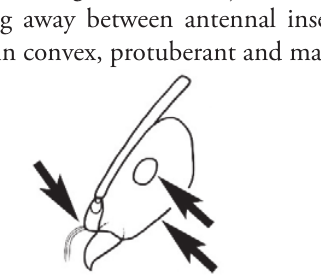
In profile, minor worker propodeum weakly truncate or rounded, descending into its declivitous face at an angle of about forty-five degrees; minor worker eye moderate (EI 19-30); minor worker antennal scape longer (SI to 120); mesosoma and first gastral tergite occasionally with one or a couple of erect setae in eastern populations; major worker morphologically similar to the following, but larger (HW of measured major worker 1.05 mm)